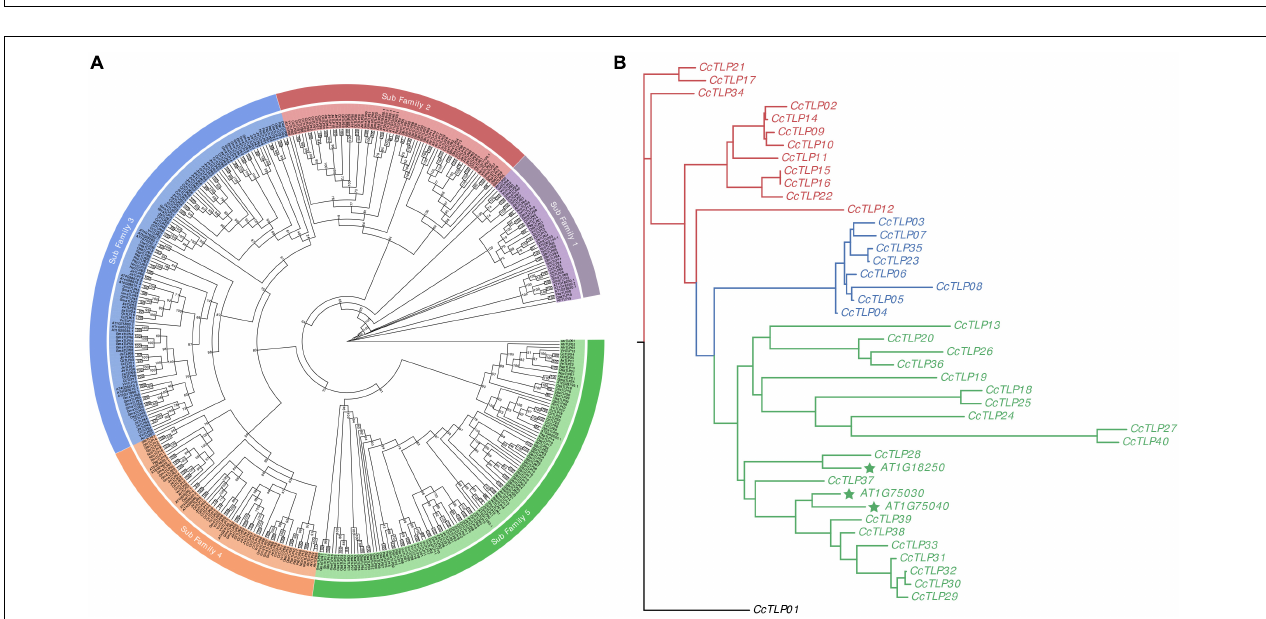
FIGURE 2 | Hickory phylogenetic tree constructed with 424 plant TLP genes (A) and full-length peptides sequences of 40 and three TLPs from hickory and three Arabidopsis thaliana , respectively (B). The phylogenetic tree of 424 plant TLP genes was plotted with the maximum-likelihood estimation, JTT + R7 substitution model, and 1,000 bootstrap times. The phylogenetic tree was divided into five clades: Purple, dark red, blue, orange, and green. The 43 TLP peptides sequences were aligned using the MAFFT software. Then, the phylogenetic tree was inferred with IQTree with the parameters of the JTT + I + G4 substitution model and 1,000 times bootstrap. The maximum-likelihood tree could be divided into three groups, presented by red, green, and blue lines.